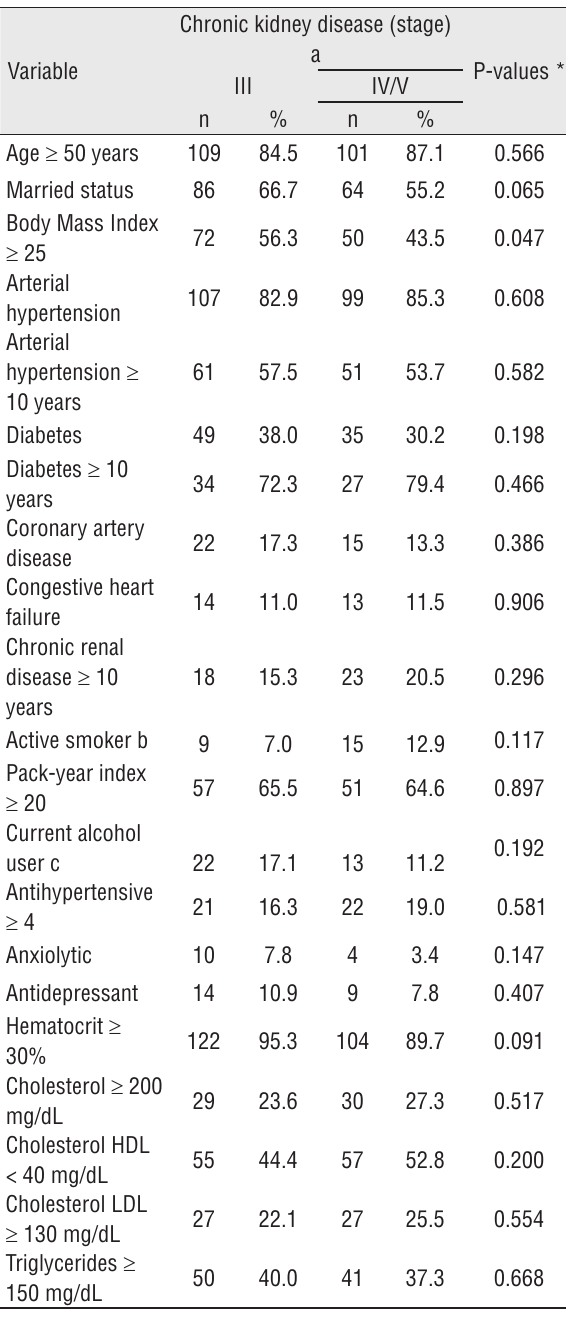
Table 2 - Patients with chronic kidney disease on conservative treatment, stage III versus stage Iv/v. Pairing among main variables that could influence erectile